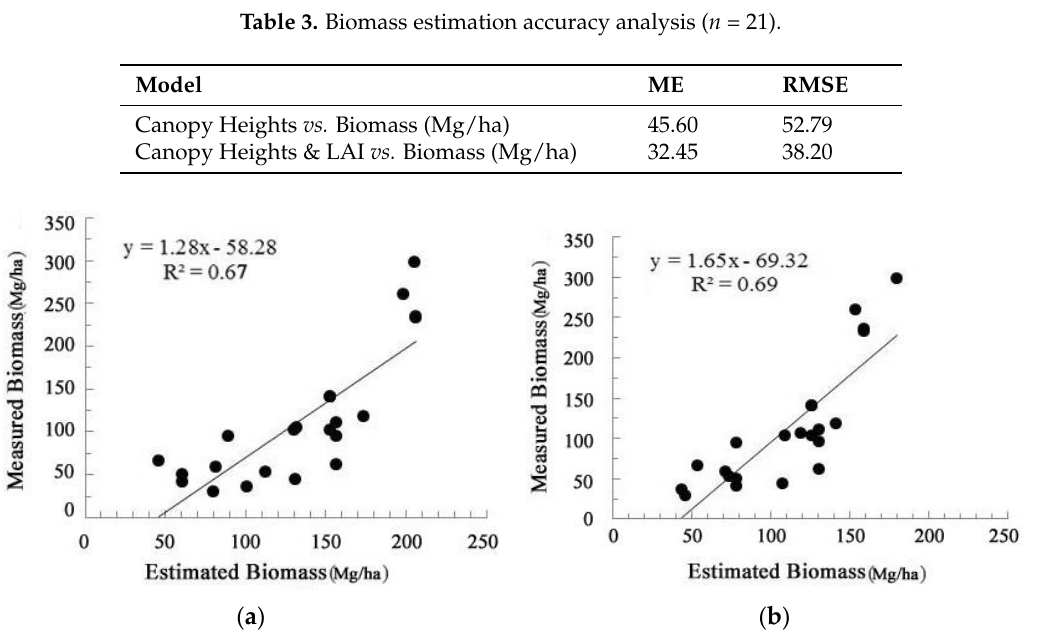
Table 3. Biomass estimation accuracy analysis ( n = 21).